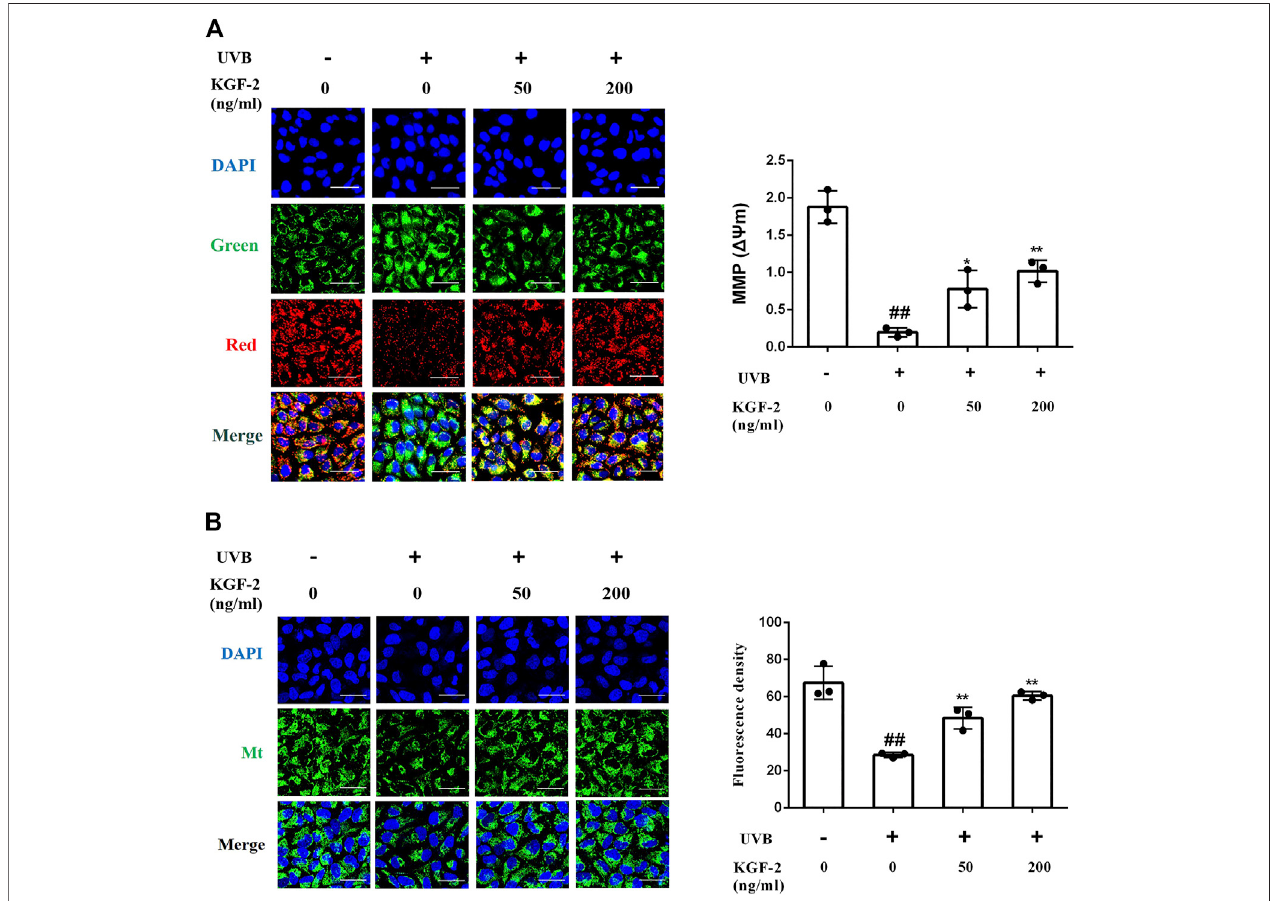
FIGURE3| EffectofKGF-2onthemitochondrialdysfunctioninducedbyofUVBirradiation.HaCaTcellswereincubatedwithKGF-2(0,50,200 ng/ml)for4 h,then exposedtoUVB(200 mJ/cm 2 )andafurther1-hincubation. (A) Representativeimageofmitochondrialmembranepotential(MMP)inHaCaTcells,theplotcomparesthe MMP of HaCaT cells from three different treatments. UVB only vs. untreated control group, p < 0.0001; KGF-2 (50 ng/ml) vs. UVB only group, p (cid:2) 0.0125; KGF-2 (200 ng/ml) vs. UVBonlygroup, p (cid:2) 0.0016. (B) Representativeimageofmitochondrialmass,theplotcomparesthemitochondrialmassofHaCaTcellsfromthree different treatments. UVB only vs. untreated control group, p < 0.0001; KGF-2 (50 ng/ml) vs. UVB only group, p (cid:2) 0.0057; KGF-2 (200 ng/ml) vs. UVB only group, p (cid:2) 0.0003.Allgraphicaldataarethemeans ± SDfromthreeindependentexperiments, “ # ” and “ ## ” indicatesigni fi cantlydifferentfromtheuntreatedcontrolgroupatthe p < 0.05 and p < 0.01 levels, respectively, “ * ” and “ ** ” indicate signi fi cantly different from the UVB only control group at the p < 0.05 and p < 0.01 levels,